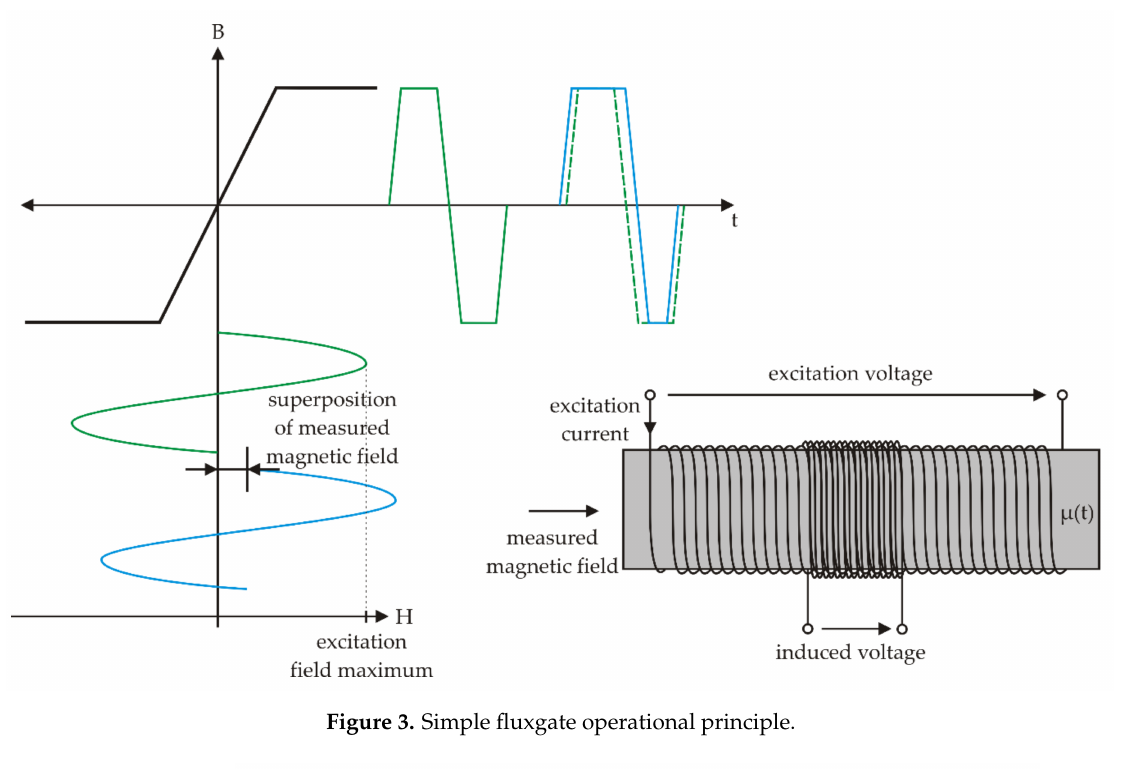
Figure 3. Simple fluxgate operational principle.